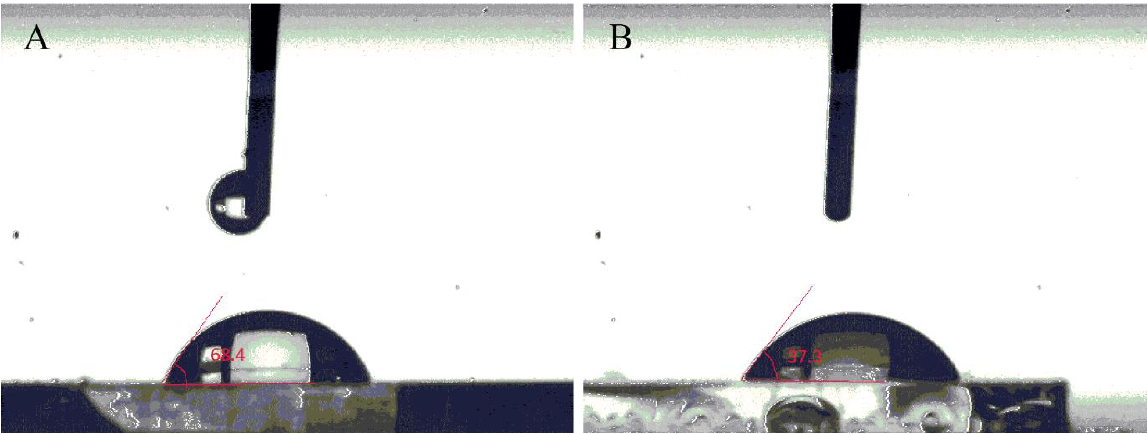
Figure 1. Contact angle: ( A ) CIP-SPR nanosensor, and ( B ) NIP-SPR. The surface depths of the CIP-SPR nanosensor were investigated using AFM in tap- ping mode. AFM images showing the three-dimensional surface structure of the bare SPR chip surface, ally-modified SPR chip surface, and coumaphos-imprinted CIP-SPR na- nosensor chip surface are shown in Figure 2A–C, respectively. The AFM images deter- mined the surface depth of the bare SPR chip, ally-modified SPR chip, and CIP-SPR na- nosensor as 9.68 ± 0.96 nm, 16.70 ± 2.17 nm and 64.30 ± 1.71 nm, respectively. The differ- ence between the surface depth values of the bare SPR chip and the CIP-SPR nanosensor indicates that the imprinted polymeric nanostructure was incorporated onto the chip sur- face successfully.